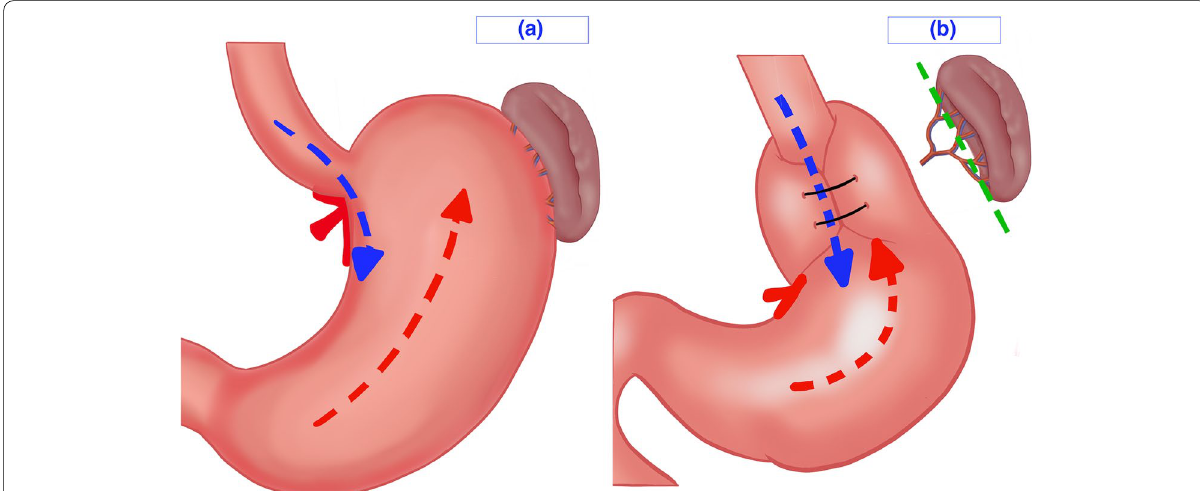
Fig. 2 a The physiological inclination angle between the esophagogastric axis (the blue dotted line), and the pyloro-dome axis for the antiperistaltic waves (the red dotted line). b A Floppy Nissen wrap created from a mobilized fundus; the designed wrap exposed to the expanding pressured waves generated within the grinding pyloric antrum